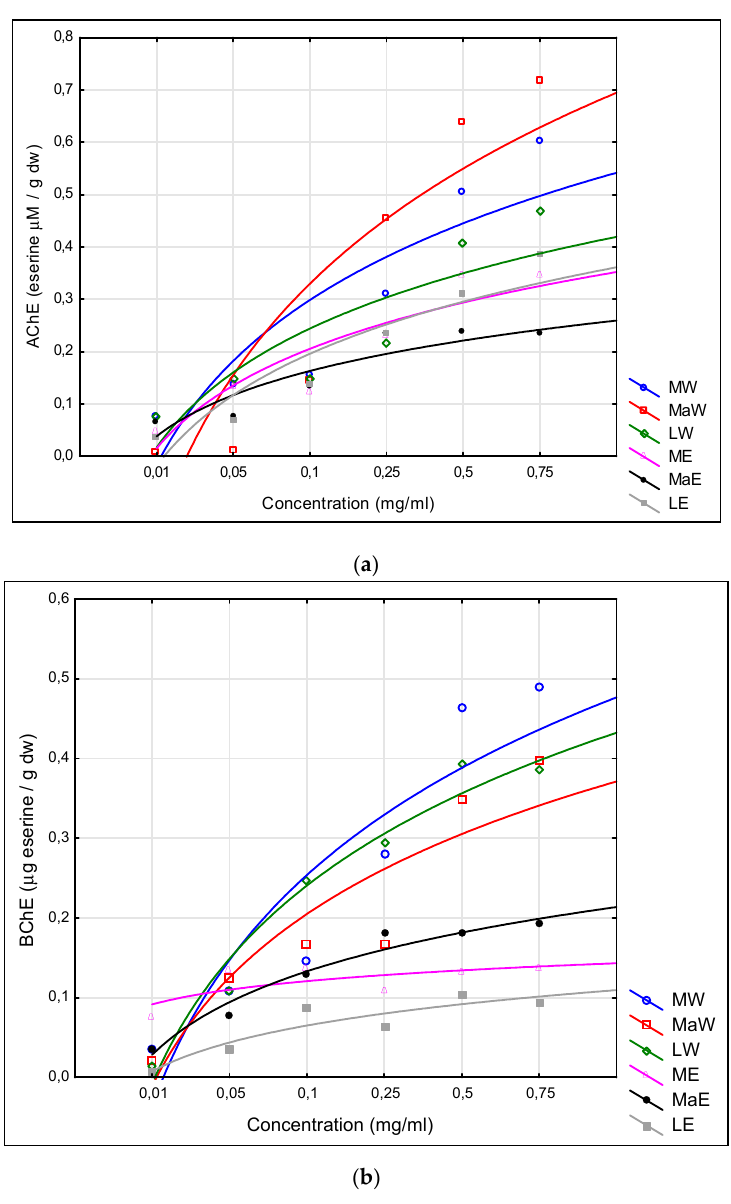
Figure 2. Activity of extracts of Humulus lupulus hops as acetylcholinesterase ( a ) and butyrylcholinesterase ( b ) inhibitors.